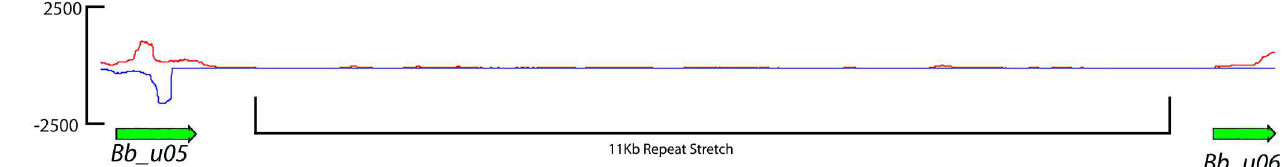
Fig 3. Example of an extensive, untranscribed sequence of B . burgdorferi . Read coverage histograms of the 11kb direct-repeatsequence within the naturally-occurring plasmid lp21. Red lines indicate relative transcript abundancefrom the + strand (left to right) and blue indicate relative transcript abundance from the–strand (right to left), and reside above (+) and below (-) the central axis. Genes are noted below coverage plots and directionality is indicatedby arrows at the ends of genes. Relative orientation of genes on the X axis is consistent with RefSeq annotations. Coverageper base is given on the Y axis to the right of the